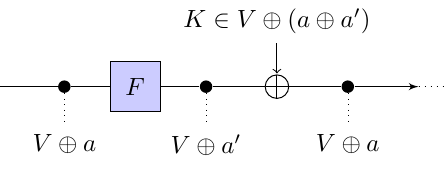
Figure 1: Invariant subspaces.